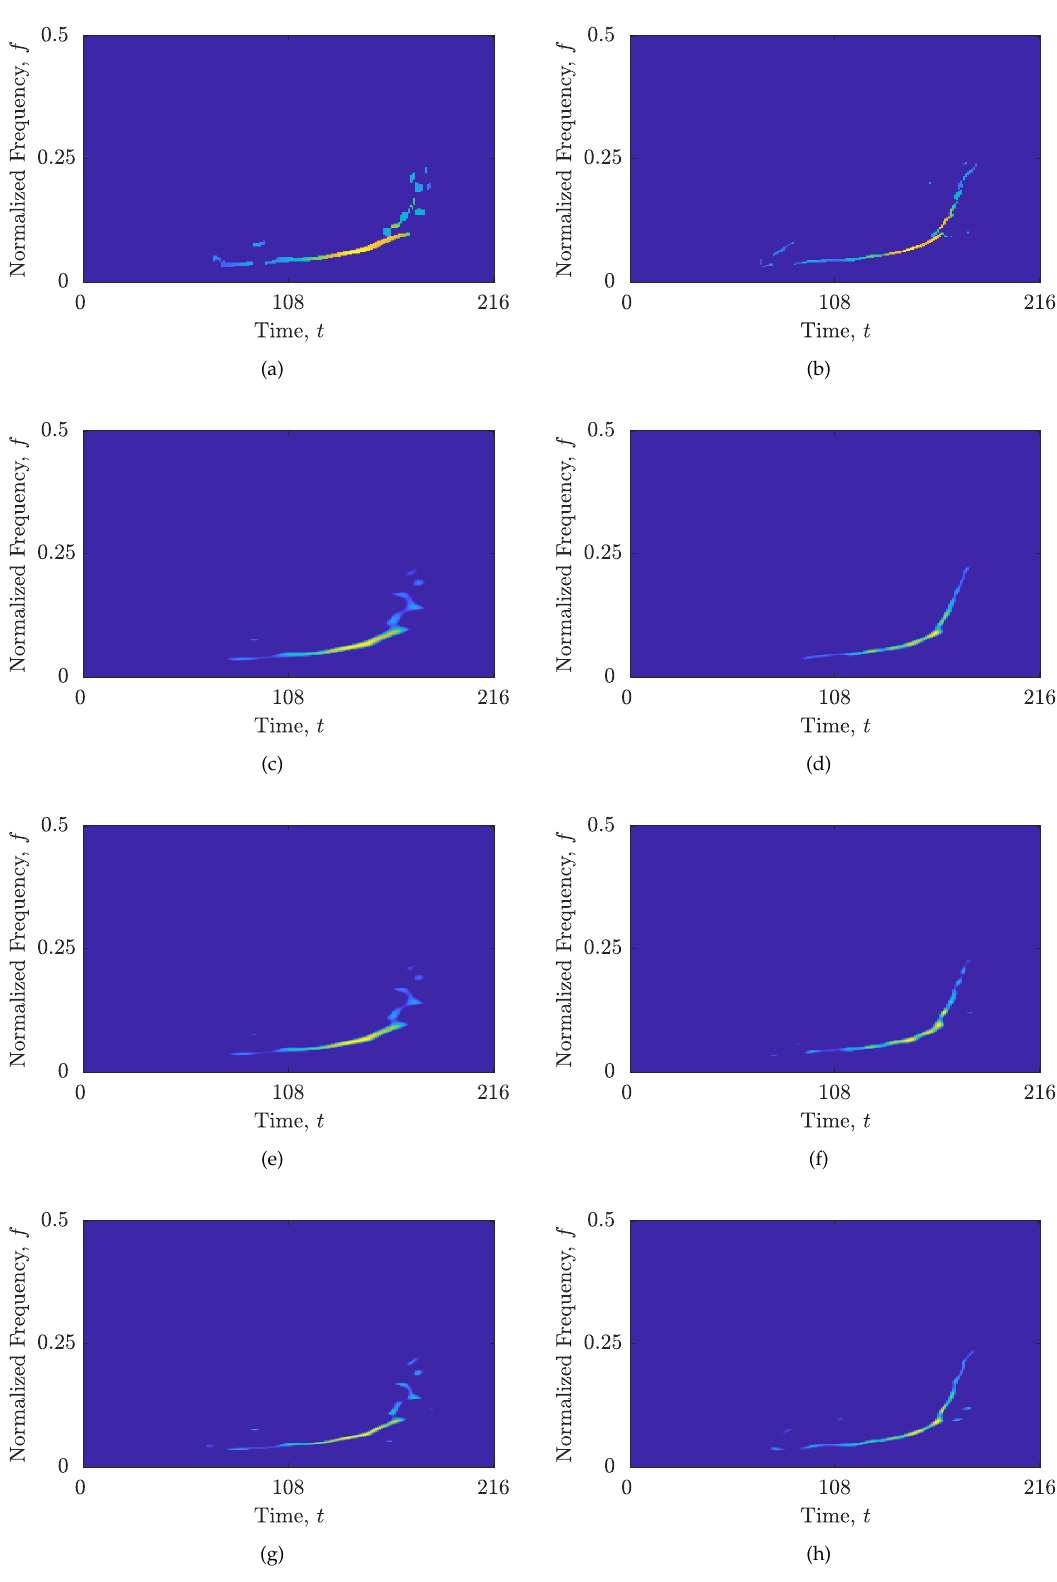
Figure 7. Reconstructed sparse TFDs of z RS with: ( a ) RTwIST algorithm, Γ = 0, Υ = 1; ( b ) RTwIST algorithm, Γ = 0.142, Υ = 0.189; ( c ) TwIST algorithm, Γ = 0, Υ = 1; ( d ) TwIST algorithm, Γ = 0.3, Υ = 0.179; ( e ) SpaRSA algorithm, Γ = 0, Υ = 1; ( f ) SpaRSA algorithm, Γ = 0.08, Υ = 0.195; ( g ) SALSA algorithm, Γ = 0, Υ = 1; ( h ) SALSA algorithm, Γ = 0.098, Υ =